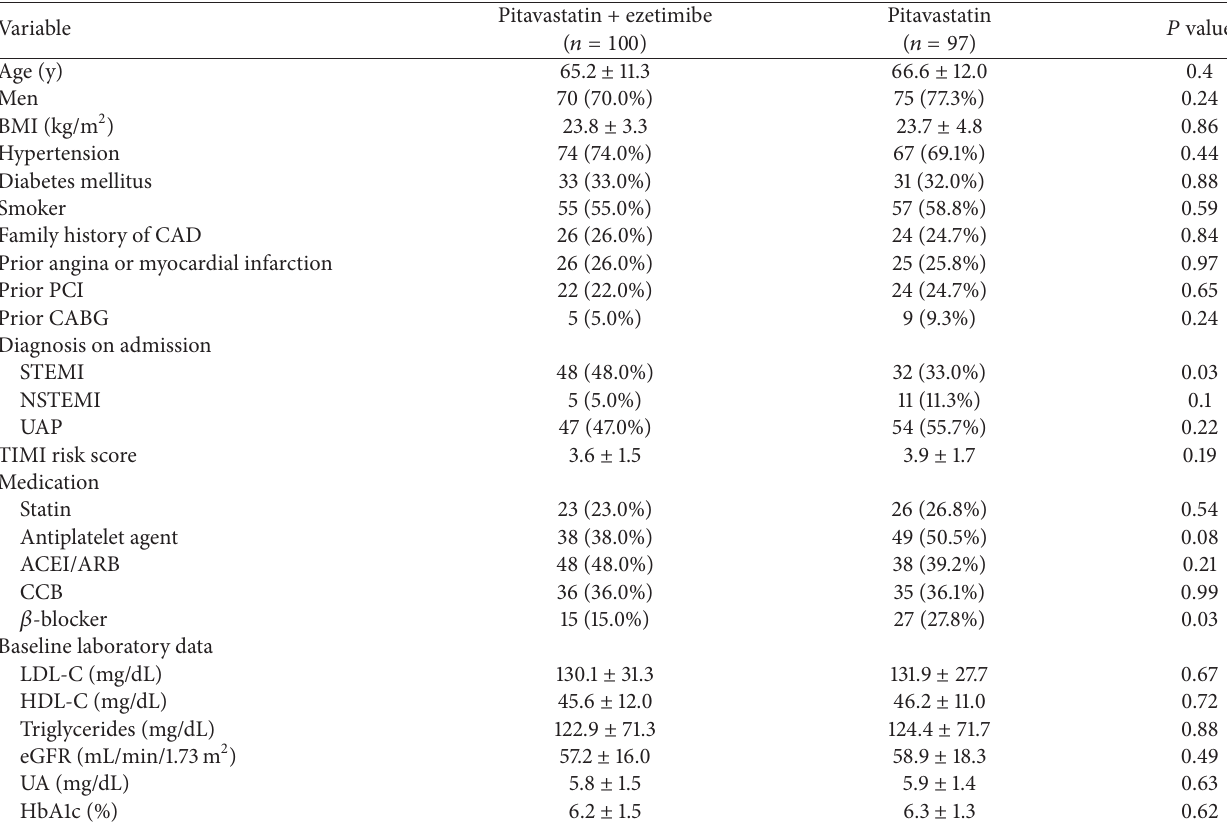
Table 1: Baseline characteristics of patients in the study